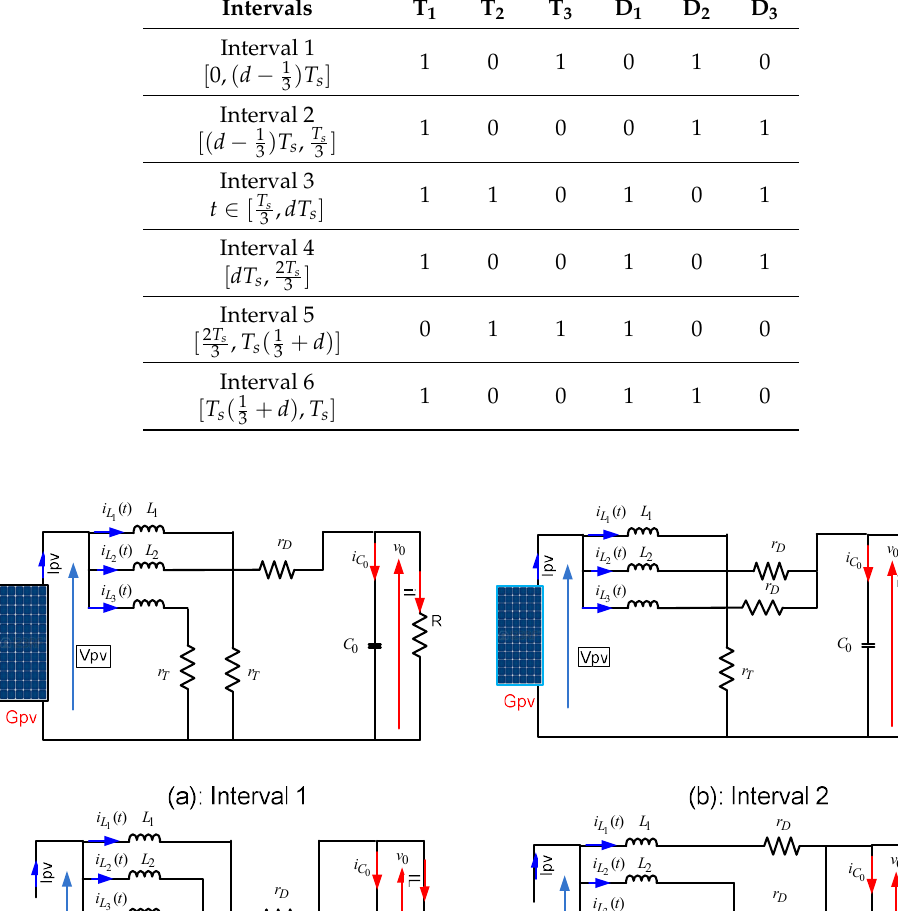
Table 2. Recap of the stats switches.